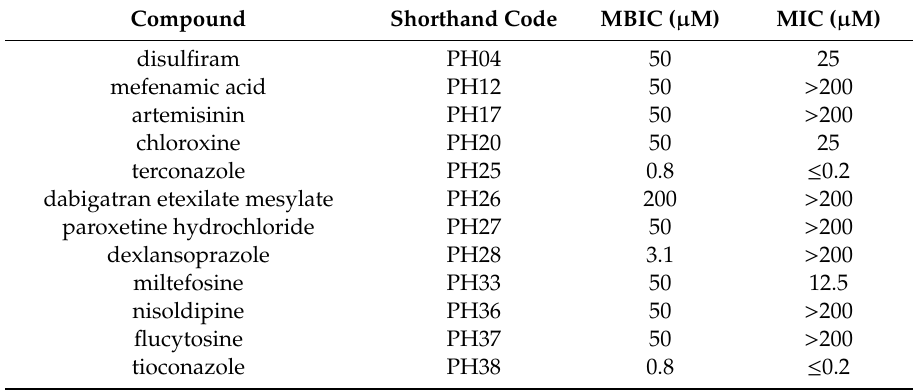
Planktonic MICs and sustained inhibition optical density biofilm assay MBICs of selected